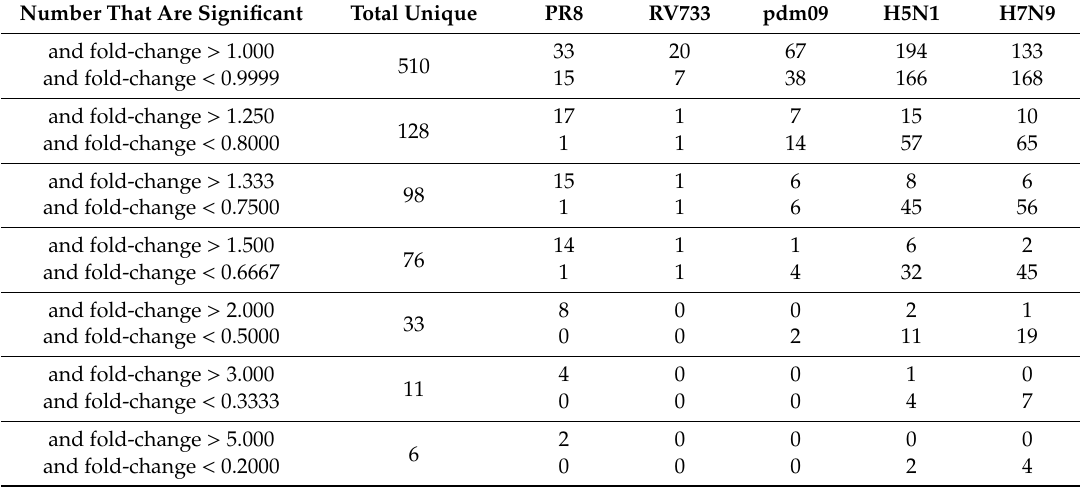
Table 1. Numbers of significantly dysregulated A549 proteins induced by each Influenza A virus (IAV) strain.